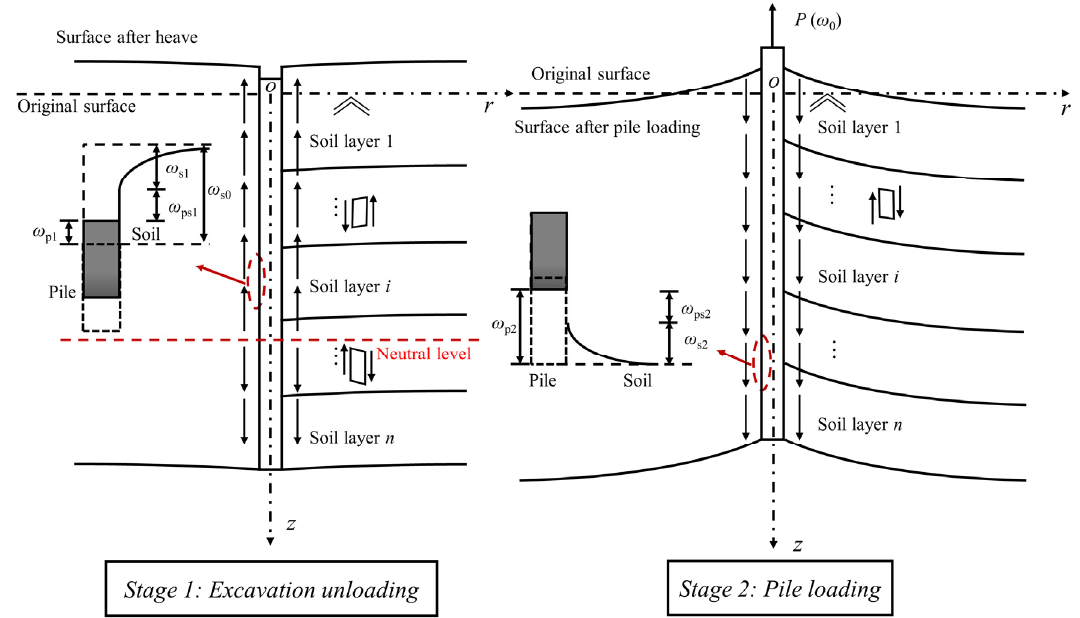
Figure 1. Pile behavior during excavation unloading and pile loading.